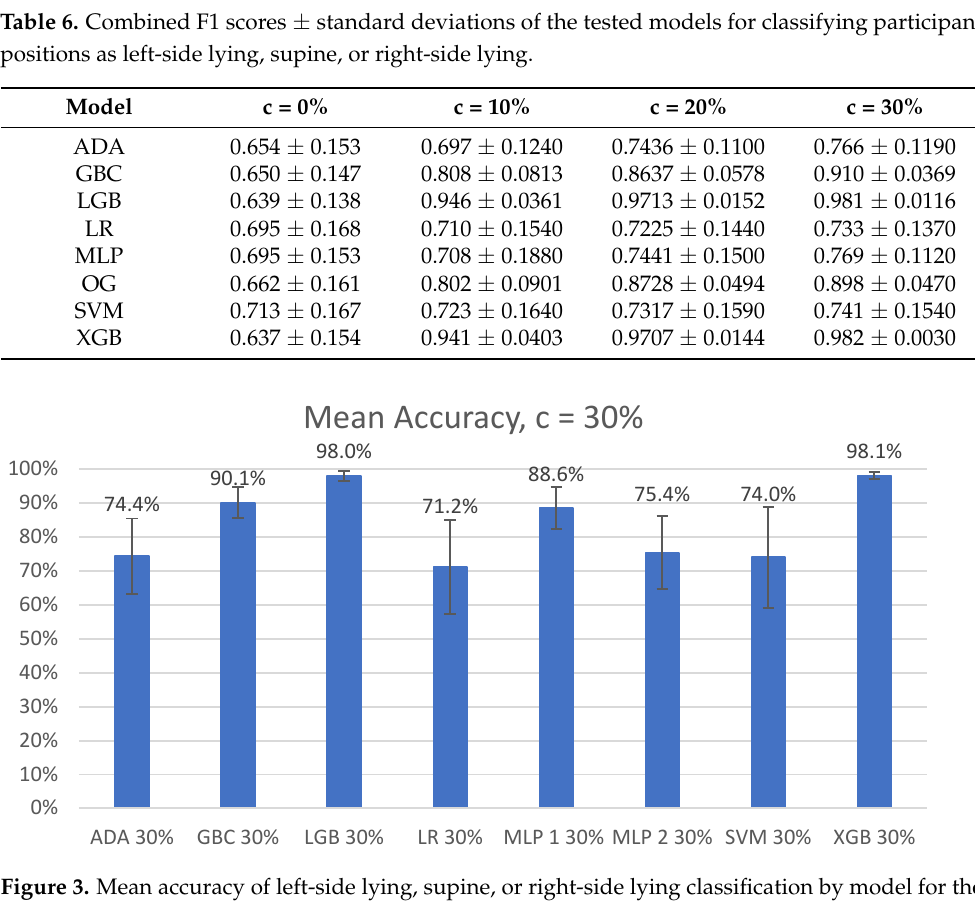
Figure 4. Mean F1 scores of left-side lying, supine, or right-side lying classification by model for the incremental learning level c = 30%. Error bars represent standard deviations. 3.2.1. Mean Accuracy The overall mean accuracy and F1 scores and their standard deviations across all nine participants for the classification of left-side lying, supine, or right-side lying at each in- cremental learning level for each model are represented in Tables 5 and 6. Figures 3 and 4 show the mean accuracy for each model at 30% incremental learning. Further comparisons of performance were performed at the c = 30% incremental learning level since these clas- sifiers consistently outperformed classifiers at the other incremental learning levels. The post hoc Wilcoxon signed-rank tests of the top three models (GBC, LGB, and XGB) with Bonferroni corrections ( p < 0.017) demonstrated significant differences between the GBC and LGB models (V = 0, p < 0.01) and between the XGB and GBC models (V = 0, p < 0.01). No significant difference in the mean accuracies was found between LGB and XGB (V = 13, p = 0.933). 3.2.2. F1 Scores The Shapiro –Wilk and Levene’s tests demonstrated that the F1 scores were normally distributed and were not homogenous (F(7,64) = 3.682, p < 0.01). Significant differences